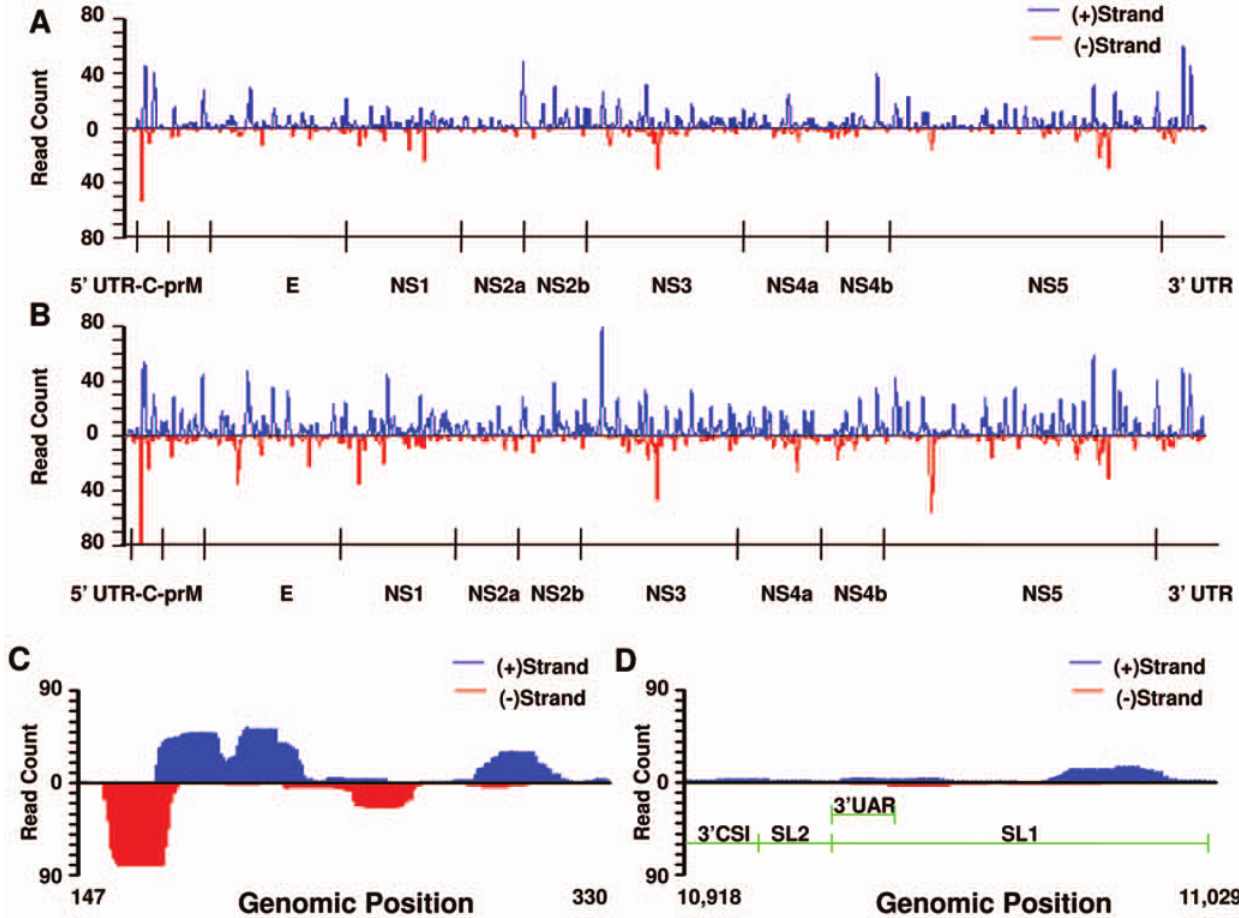
Figure 2. viRNA Coverage of WNV Genome at 7 and 14 Days Post Infection. Complete genome of WNV showing the intensity of viRNA coverage at each nucleotide of the genome at 7 (A) and 14 (B) days postfeeding. Reads originating from the positive strand are shown in blue, above the axis, and those originating from the negative strand are shown in red, below the axis. Particular regions appear to be preferentially targeted by the RNAi response, including the 5 9 aspect of the C coding region and the 3 9 non-coding region. Peaks are generally higher at 14 than 7 days post infection (dpi), with notable exceptions in NS2a, at the NS4b/NS5 junction and the 3 9 -UTR. Both positive and negative polarity RNA is targeted by viRNAs generated in mosquito midgut cells. At 14 dpi, although true for both 7 and 14 dpi, the focus of viRNA targeting in the C coding sequence (C) is characterized by a relatively intense targeting of the negative strand compared to the 3 9 -UTR (D). Notably, well documented imperfect stem-loops and other critical functional RNA structures within the 3 9 -UTR do not appear to be intensely targeted by the RNAi